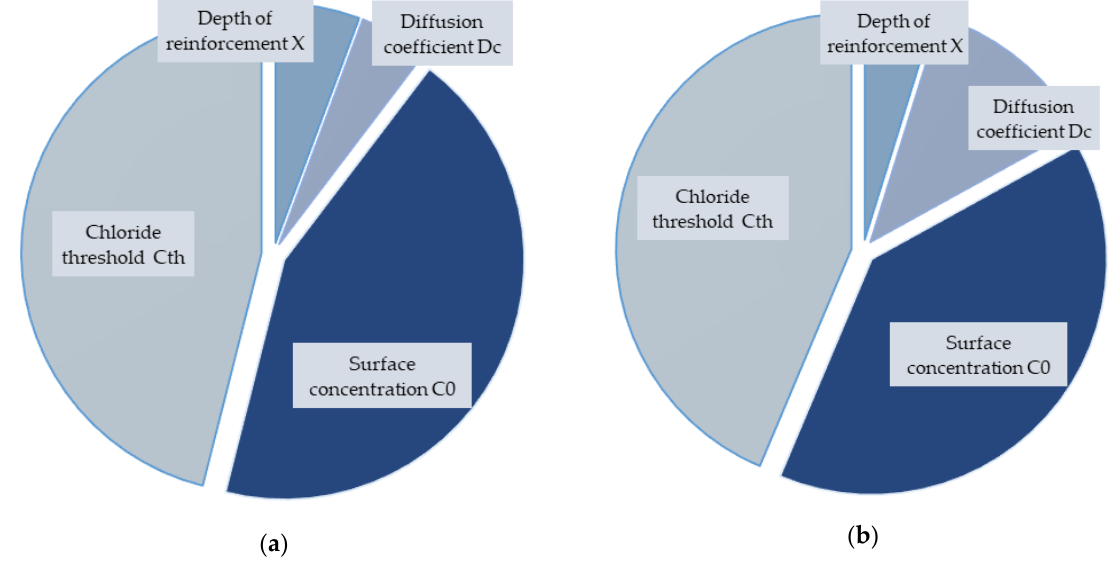
Figure 5. Degree of the influence of input parameters for all concretes: ( a ) SCC 1%, ( b ) SCC 2%.